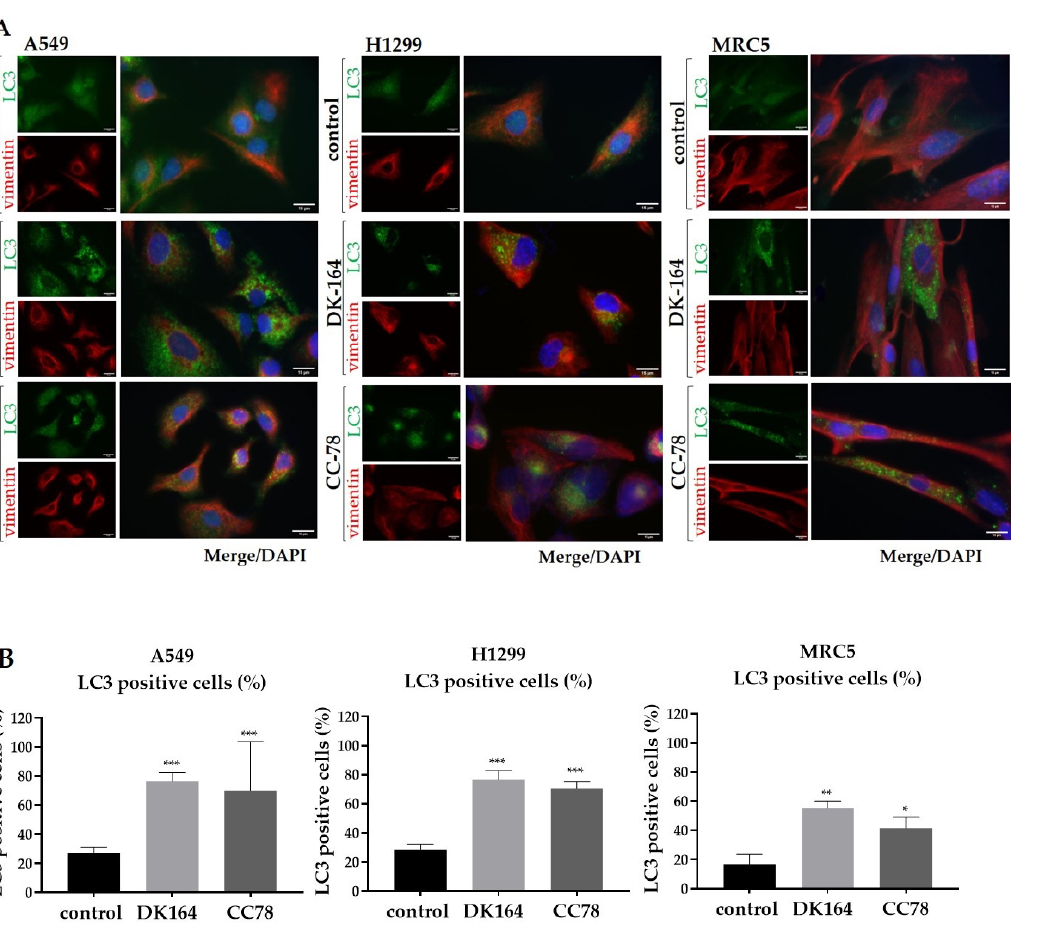
Figure 5. Detection of the autophagy marker LC3 by immunofluorescence. ( A ) Representative immunofluorescent images of A549, H1299, and MRC5 control cells and cells treated with the calculated IC50 concentrations of DK-164 and CC-78 for 24 h and incubated with anti-LC3 antibody (green) and anti-vimentin antibody (red). DNA was co-stained with DAPI (blue). ( B ) Quantitative determination of the fraction of LC3-positive cells was performed using the ImageJ quantification tool. A p -value < 0.05 was considered statistically significant, * p < 0.05, ** p < 0.01, and *** p < 0.005. Quantification is based on three independent experiments with >50 cells scored for each condition. Error bars represent standard deviation (SD). The scale bar corresponds to 15 µm.